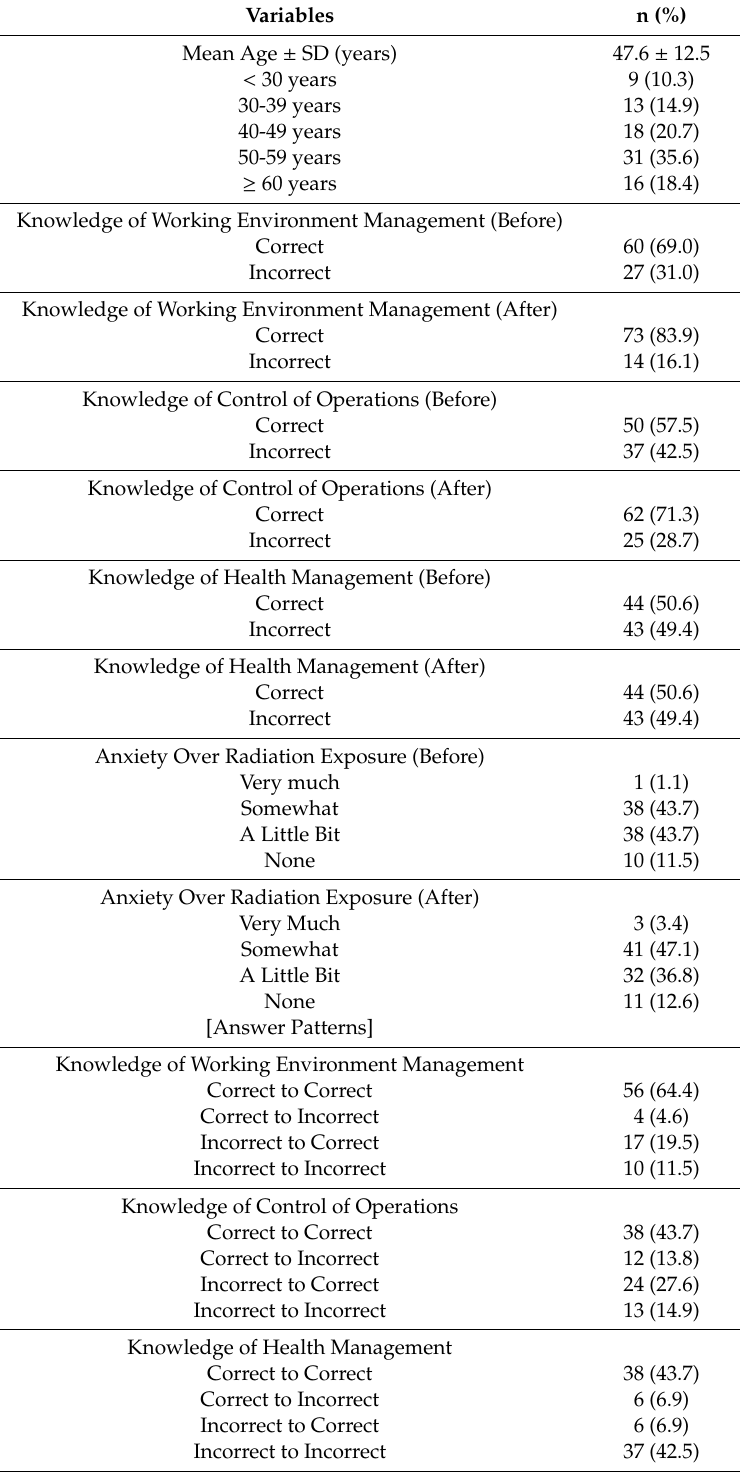
Table 1. Subject